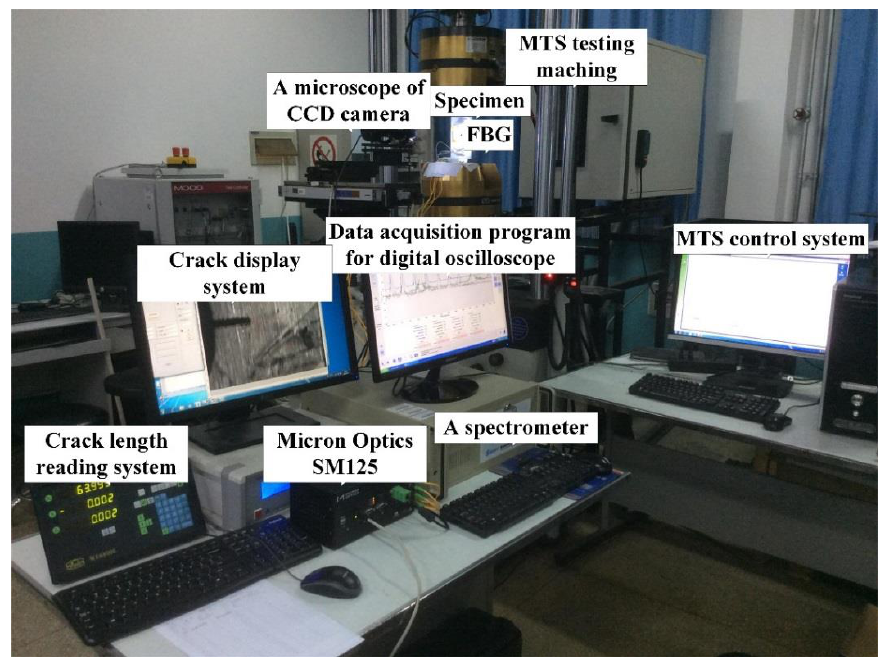
Figure 8. Experimental setup for the FBG sensor damage detection system.